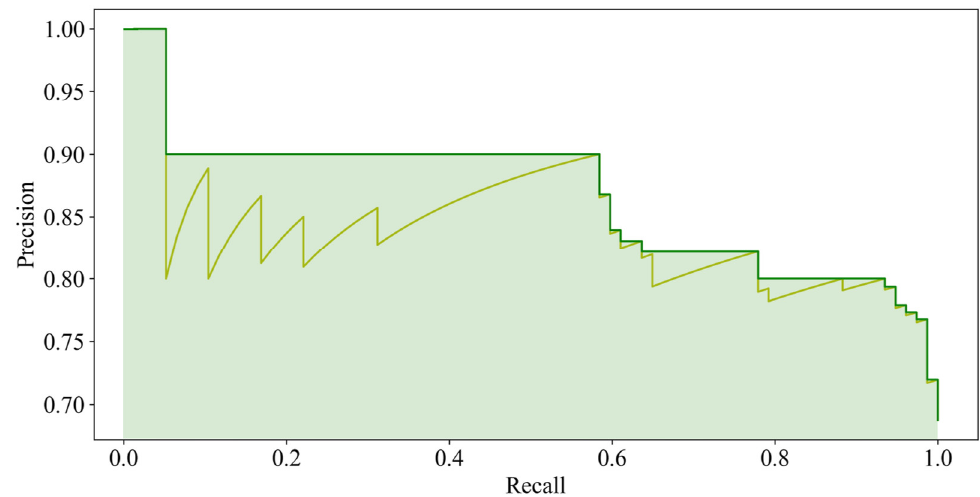
Figure 12. Visualization of recall–precision curve of the test image for AP calculation. The yellow curve depicts the precision metric in a descending power manner from the most-confident box. The area under the green curve represents AP (0.842).